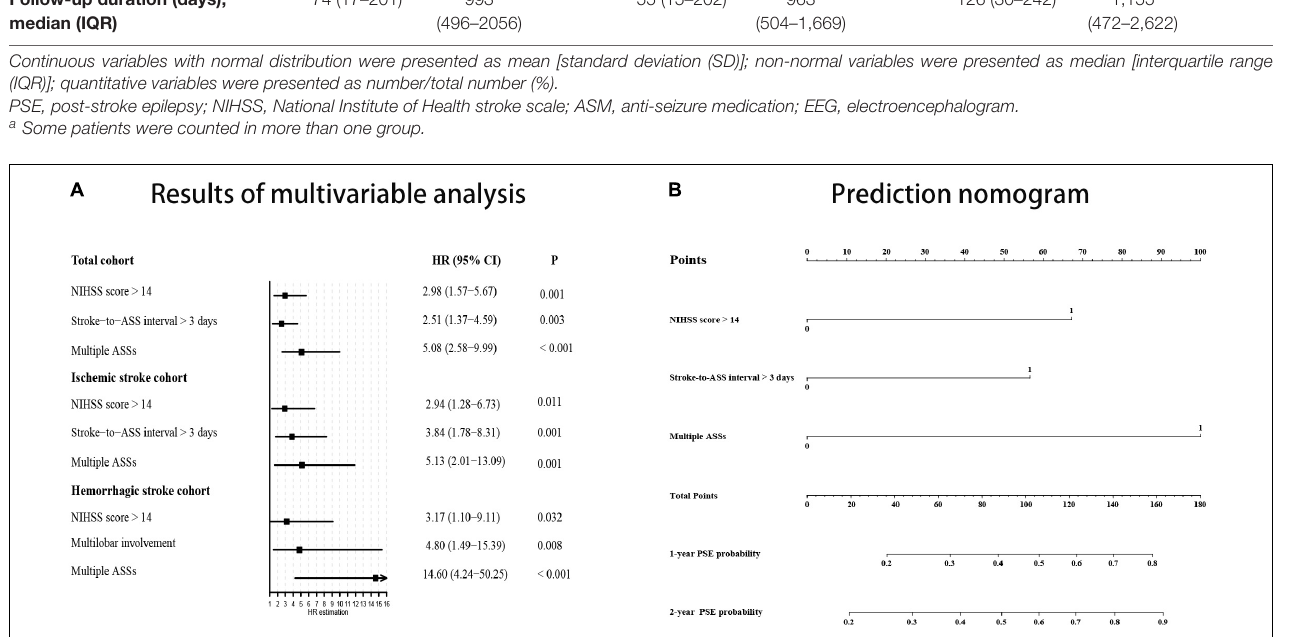
FIGURE 3 | PSE probability prediction using results of multivariable analysis. (A) Forest plot based on results of multivariable analysis. (B) Prediction nomogram on the basis of results multivariable analysis in the total cohort. NIHSS, National Institute of Health stroke scale; ASS, acute symptomatic seizure; PSE, post-stroke epilepsy; 95% CI, 95% confidence interval. TABLE 4 | Comparing NHISS score and lesion volume between patients with and without multilobar involvement in hemorrhagic stroke cohort. With multilobar involvement ( n = 16) Without multilobar involvement ( n = 40) P